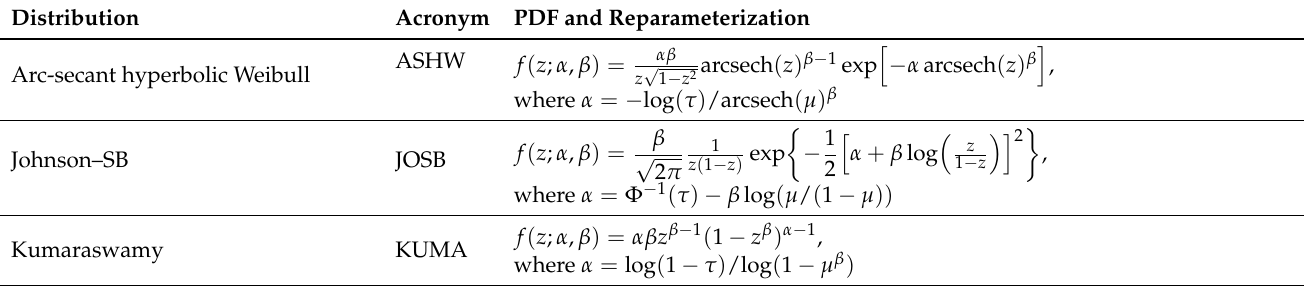
Table A1. PDF and reparameterization of the indicated distribution and its